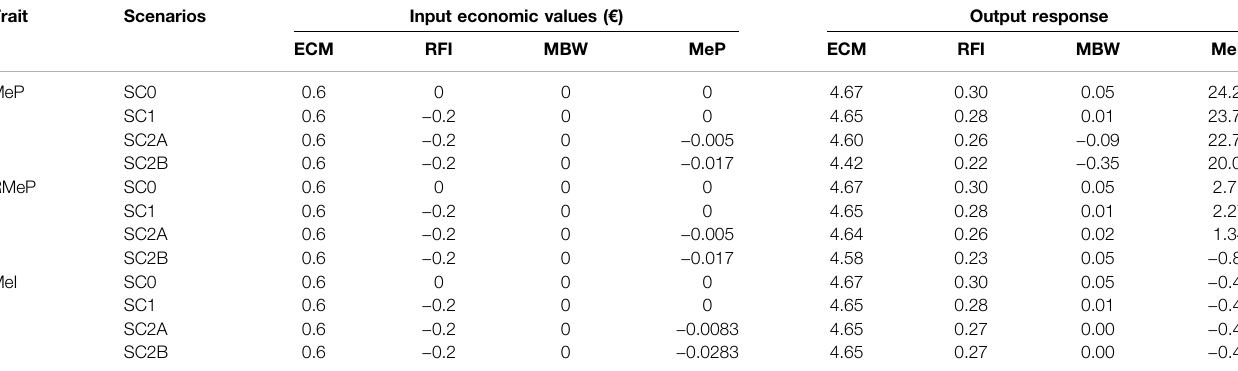
TABLE 5 | Correlated response to selection for MeP, RMeP, and MeI using ECM, MBW, and RFI. Trait Scenarios Input economic values ( €